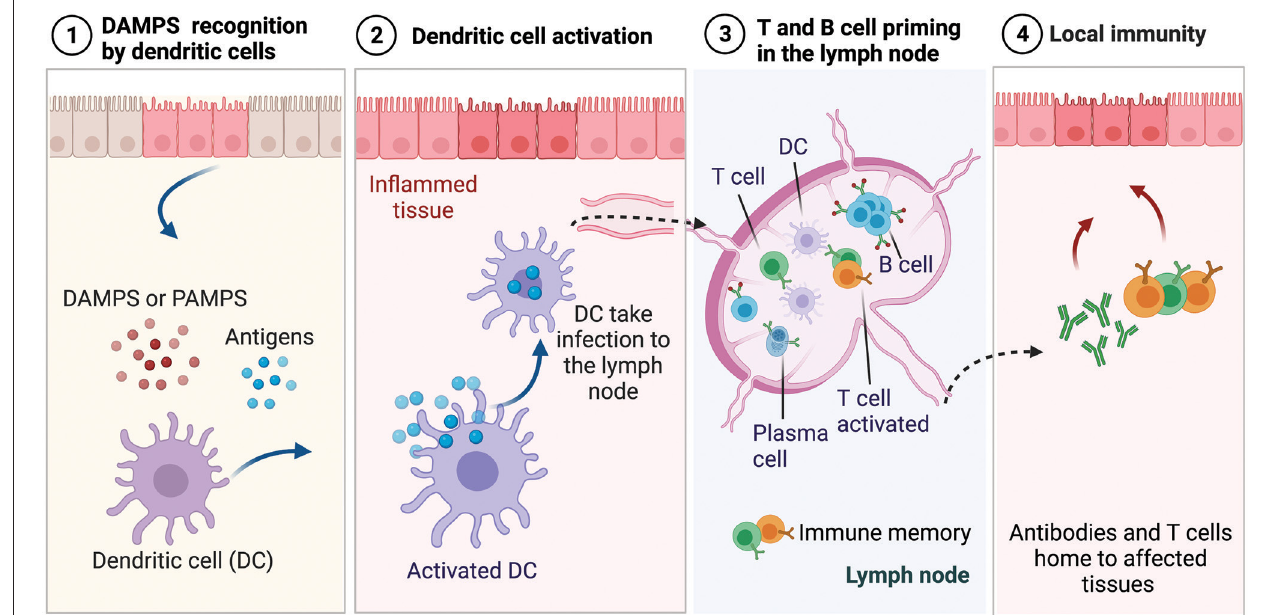
FIGURE 6 | Overview of innate immune response upon injury or